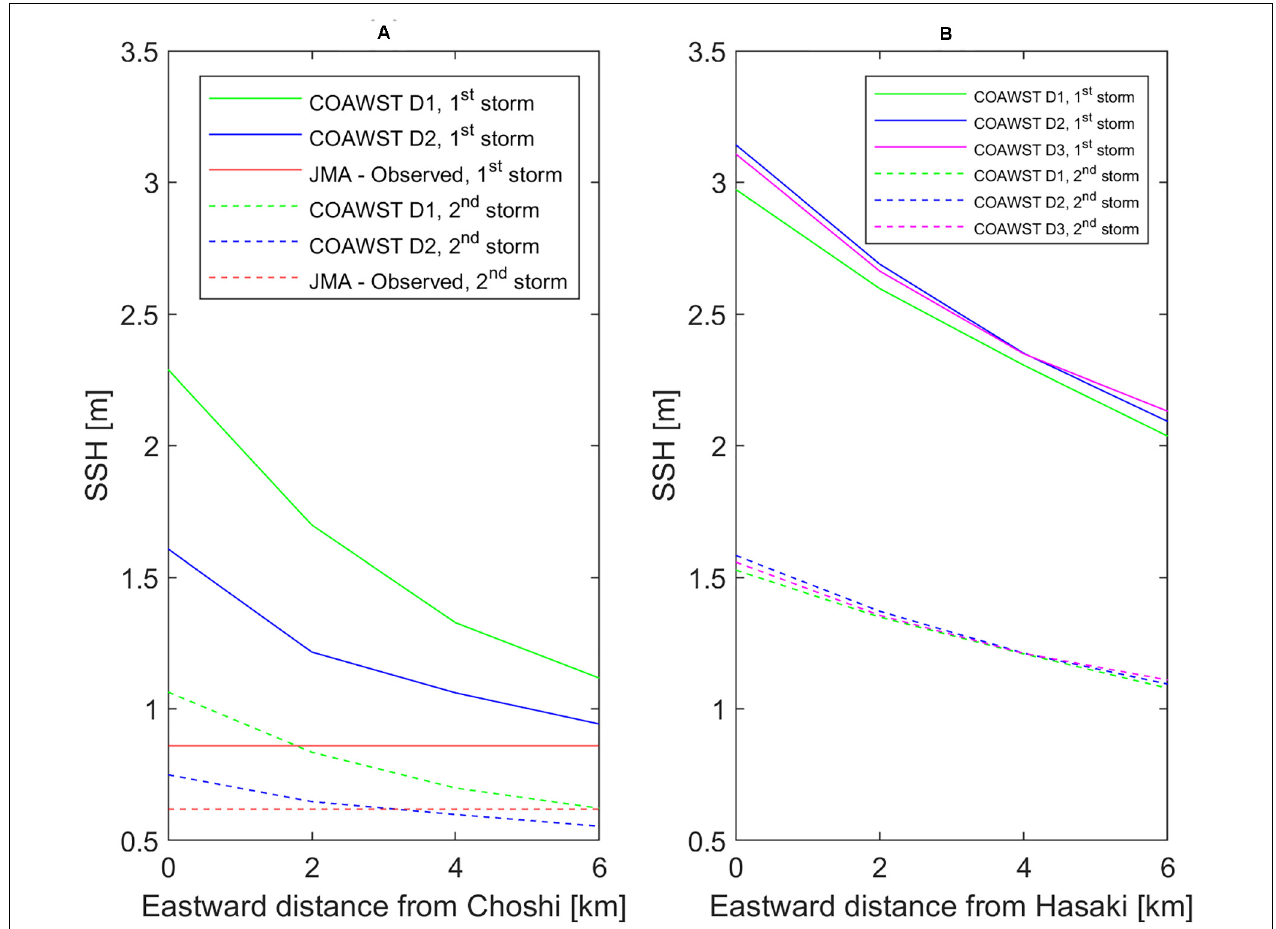
FIGURE 2 | Peak Sea Surface Height horizontal distribution from onshore to 6 km eastward offshore at (A) Choshi and (B) Hasaki for COAWST domain 1 (green), domain 2 (blue) and domain 3 (magenta, only in Hasaki) for S1 (full line) and S2 (dashed line) compared with surge data observed by JMA at Choshi Tidal Station (red, only in